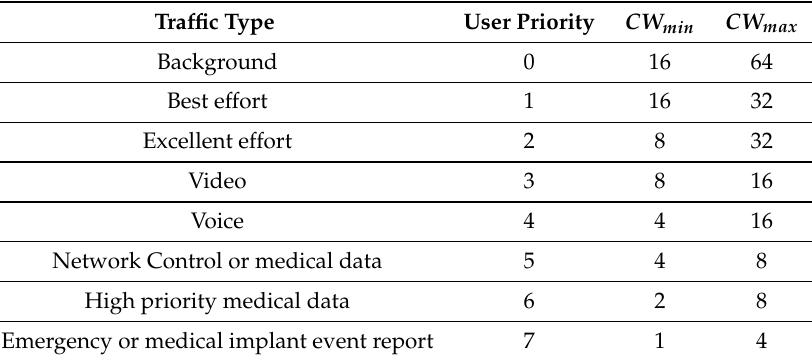
Figure 1. Channel access method of the proposed mechanism. Table 1. Maximum and Minimum CW for IEEE 802.15.6